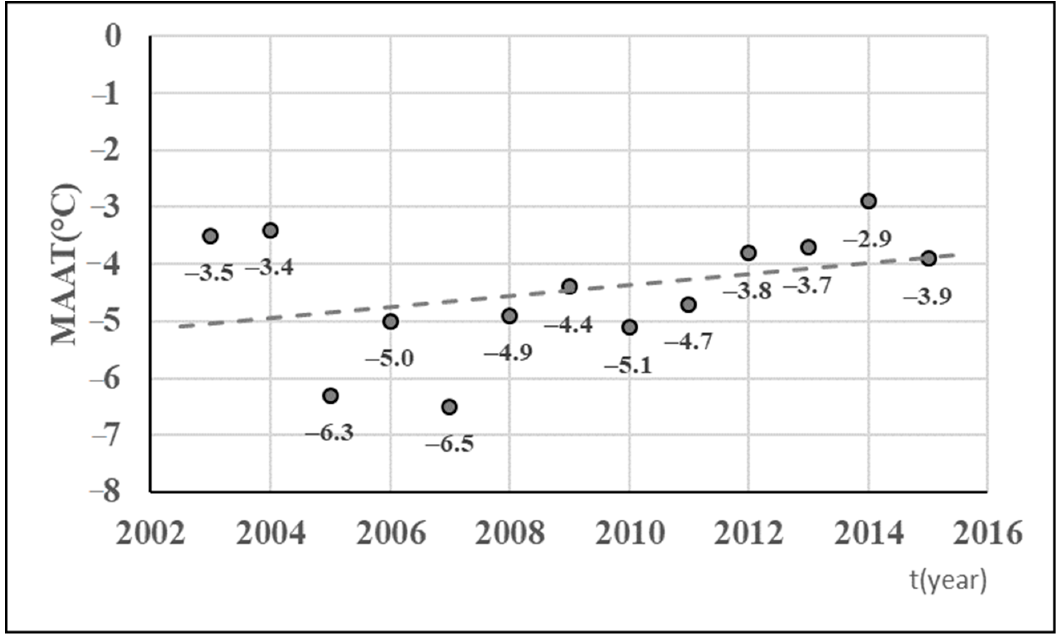
Figure 4. Snow thickness in PG1 from 2009 to 2015.